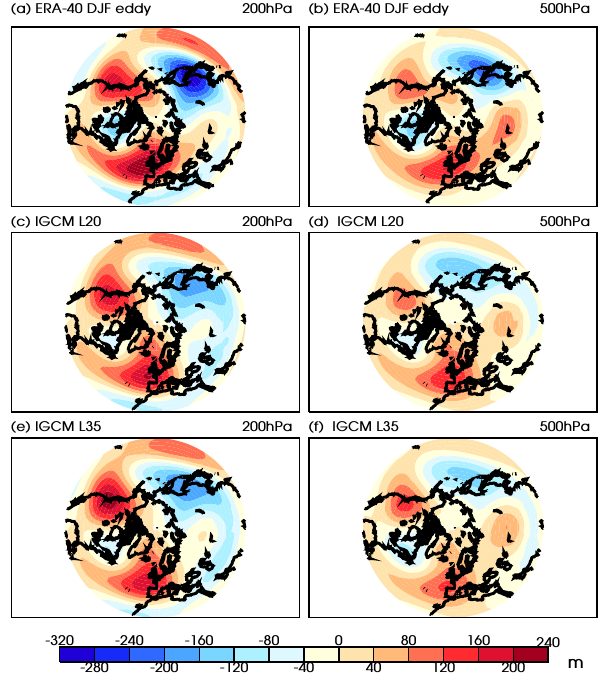
Figure 9. Geopotential height (m) DJF eddy fields for (a, b) 200hPa and 500hPa ERA-40 reanalysis respectively. The same for (c, d) IGCM4 L20 and (e, f) IGCM4 L35. For the reanalysis a mean over the years 1958–2002 is